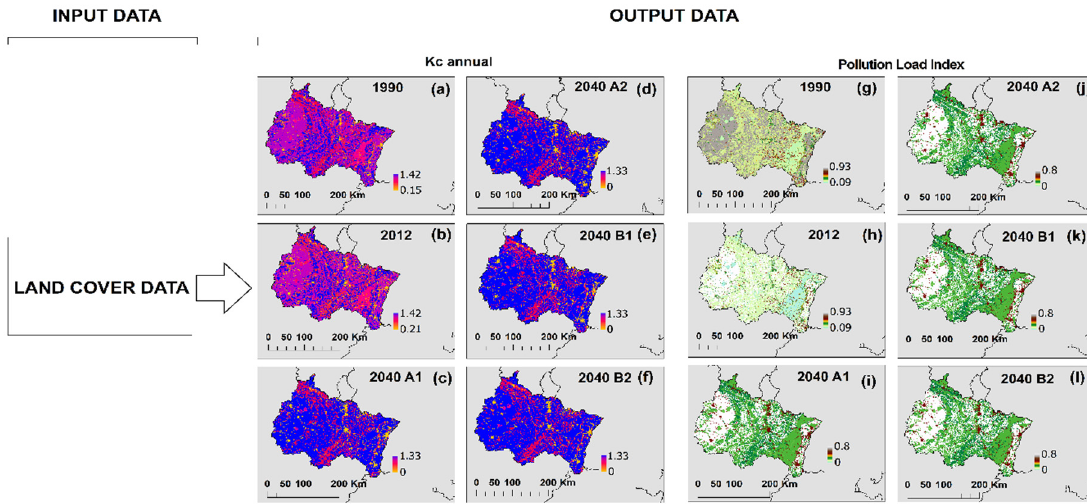
Figure 4. Spatial distribution of crop coefficient (Kc) and pollution load index (PLI) in the Grand Est region. ( a ) Kc in 1990s. ( b ) Kc in 2012. ( c ) Kc in 2040, Scenario A1. ( d ) Kc in 2040, Scenario A2. ( e ) Kc in 2040, Scenario B1. ( f ) Kc in 2040, Scenario B2. ( g ) PLI in 1990s. ( h ) PLI in 2012. ( i ) PLI in 2040,